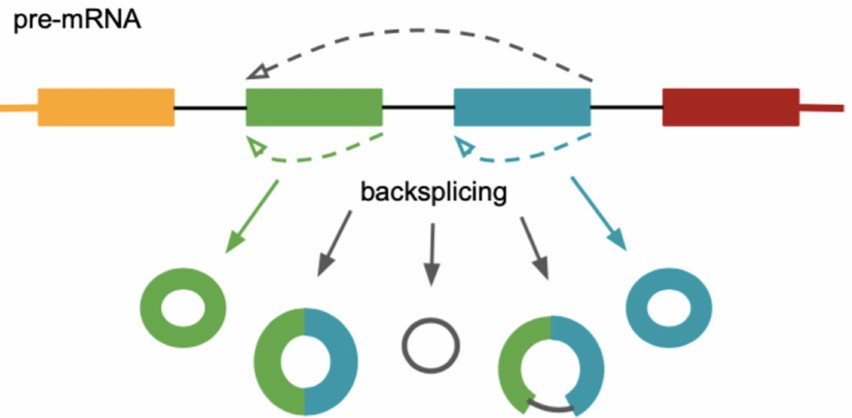
Figure 3. circRNAs formation by backsplicing (pre-mRNA splicing at a reversed order in which a downstream splice donor is joined to an upstream splice